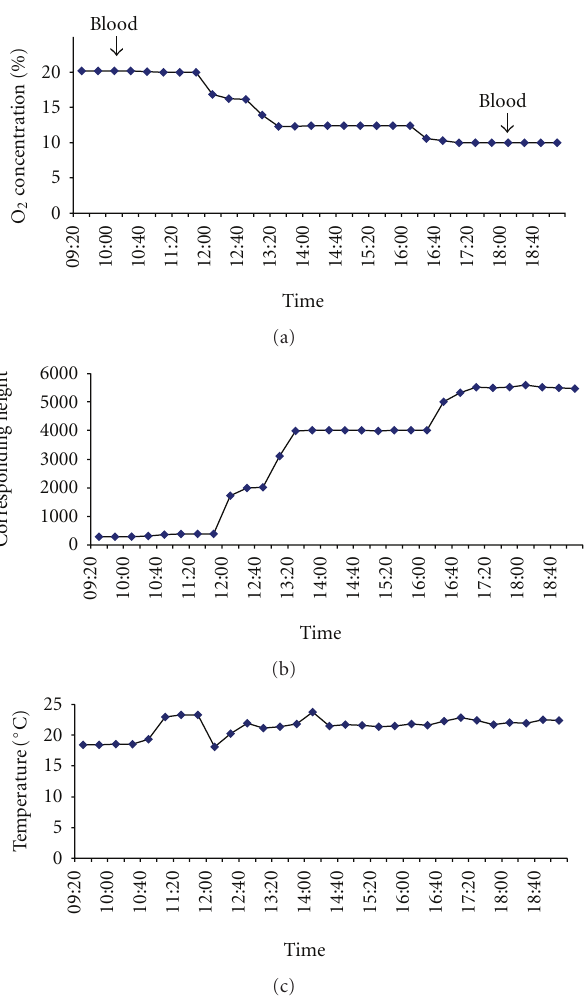
DE19711, EPO and VEGF RandD Systems, Germany) according to the manufacturers’